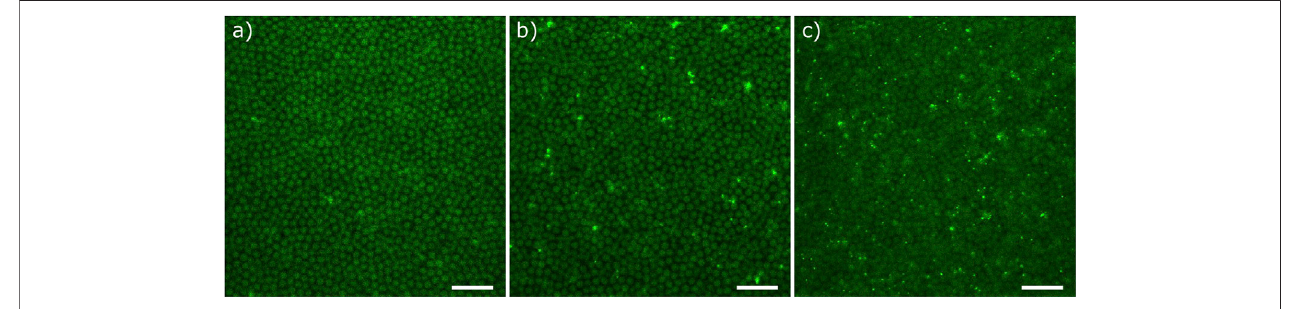
FIGURE 5 | Highlighting the immobile particles. The minimum intensity projection of the image sequence for ϕ = 0.60 (A) , ϕ = 0.61 (B) , and ϕ = 0.62 (C) shows an increasing number of bright spots, indicating that an increasing fraction of small particles becomes immobile for increasing ϕ . The scale bars correspond to 15 μ